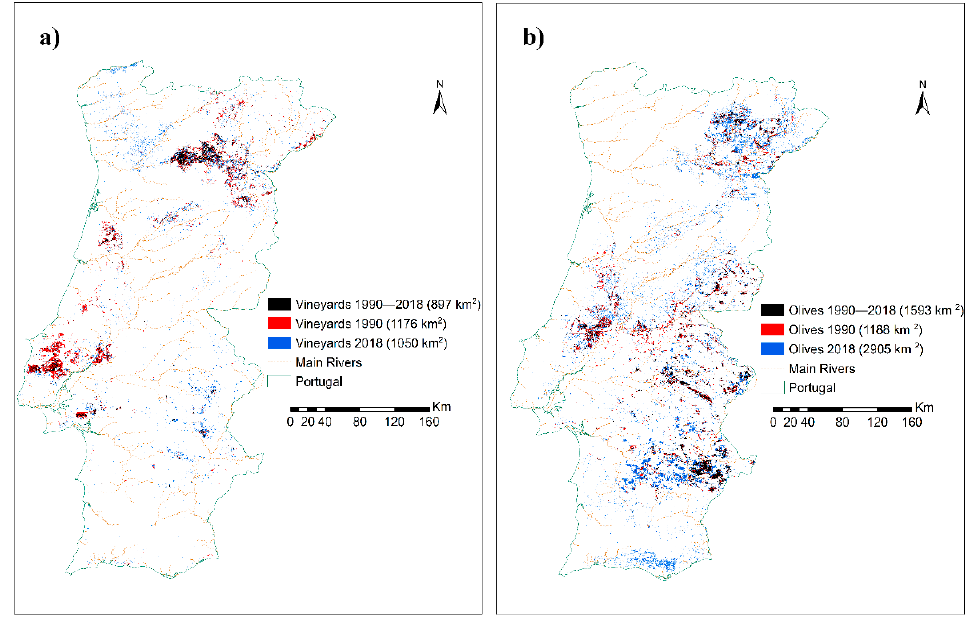
Figure 6. Spatial representation and related area (in km 2 ) of ( a ) vineyards and ( b ) olive groves in Portugal for the period between 1990 and 2018. Areas maintained throughout the period in black (persistent areas), only for 1990 in red (discontinued areas), and 2018 in blue (emerging areas).